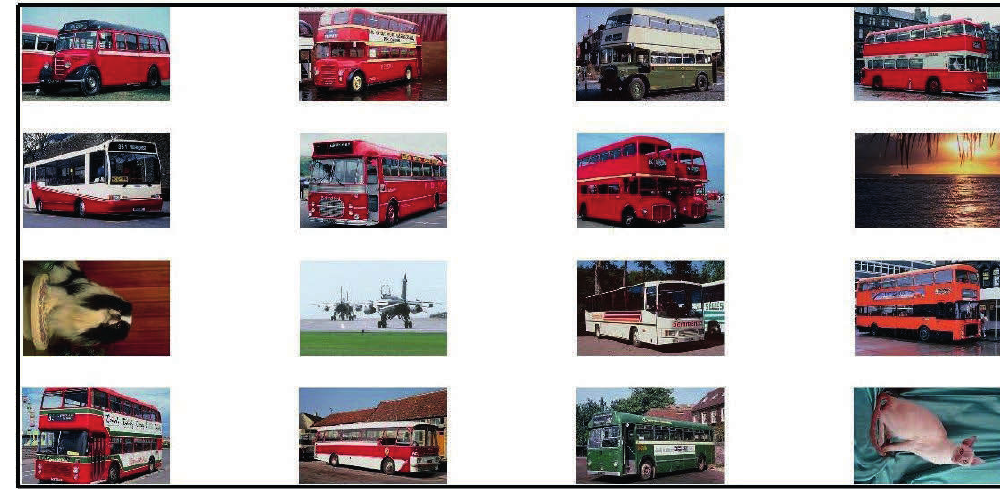
Fig. 17. Bus images retrieved using EHD based CBIR.